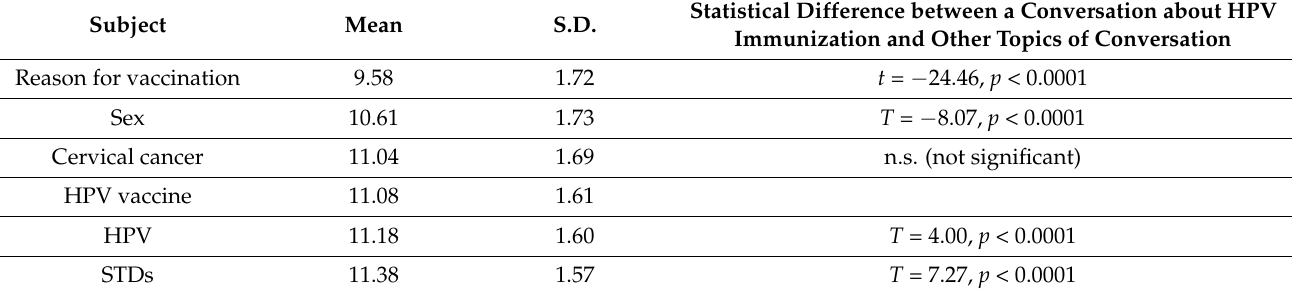
Table 7. Average age of the discussion between parents and children on HPV-related topics